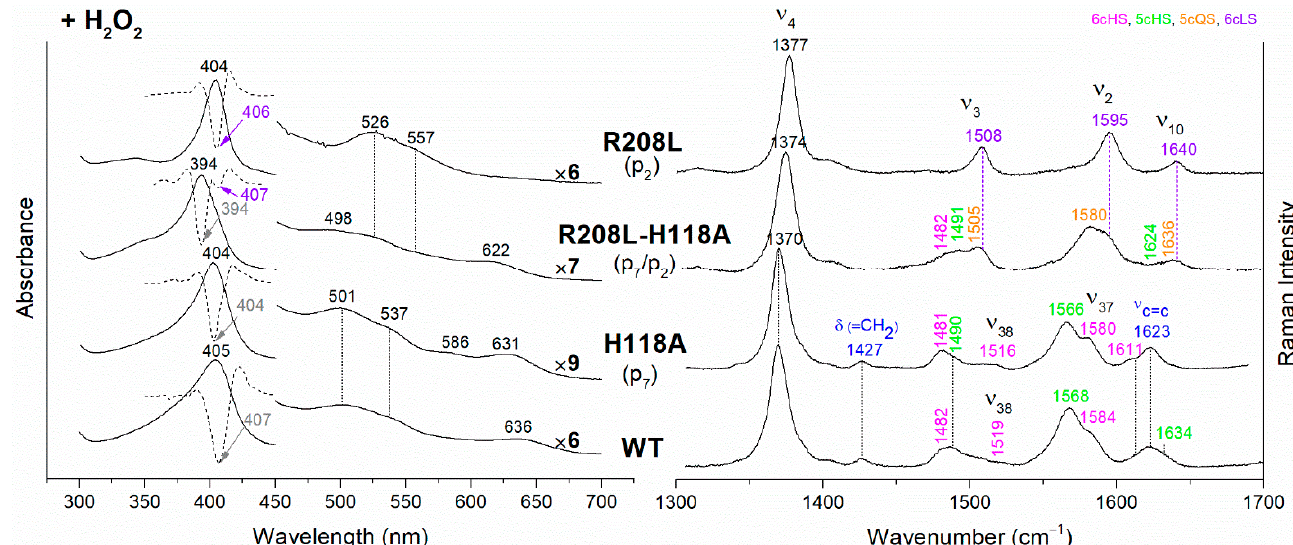
Figure 5. ( Left ) UV-vis electronic absorption spectra (solid lines) and their second derivative (dashed lines), and ( Right ) RR spectra in the high wavenumber region of coproheme complexes upon H 2 O 2 titration of Cd ChdC WT and variants. In brackets, the propionate, whose corresponding H-bond is removed by mutation, is reported. The band wavelengths assigned to the 6cLS species are indicated in violet. The RR core-size marker band wavenumbers are reported in pink, green, orange and violet for the 6cHS, 5cHS, 5cQS and 6cLS species, respectively, while in blue are indicated the vinyl vibrations ( ν C=C stretching modes and δ (=CH 2 ) bending modes), and in black, at the side of the UV-vis spectra, are indicated the expansion factors applied in the 450–700 nm spectral range for better data visualization.